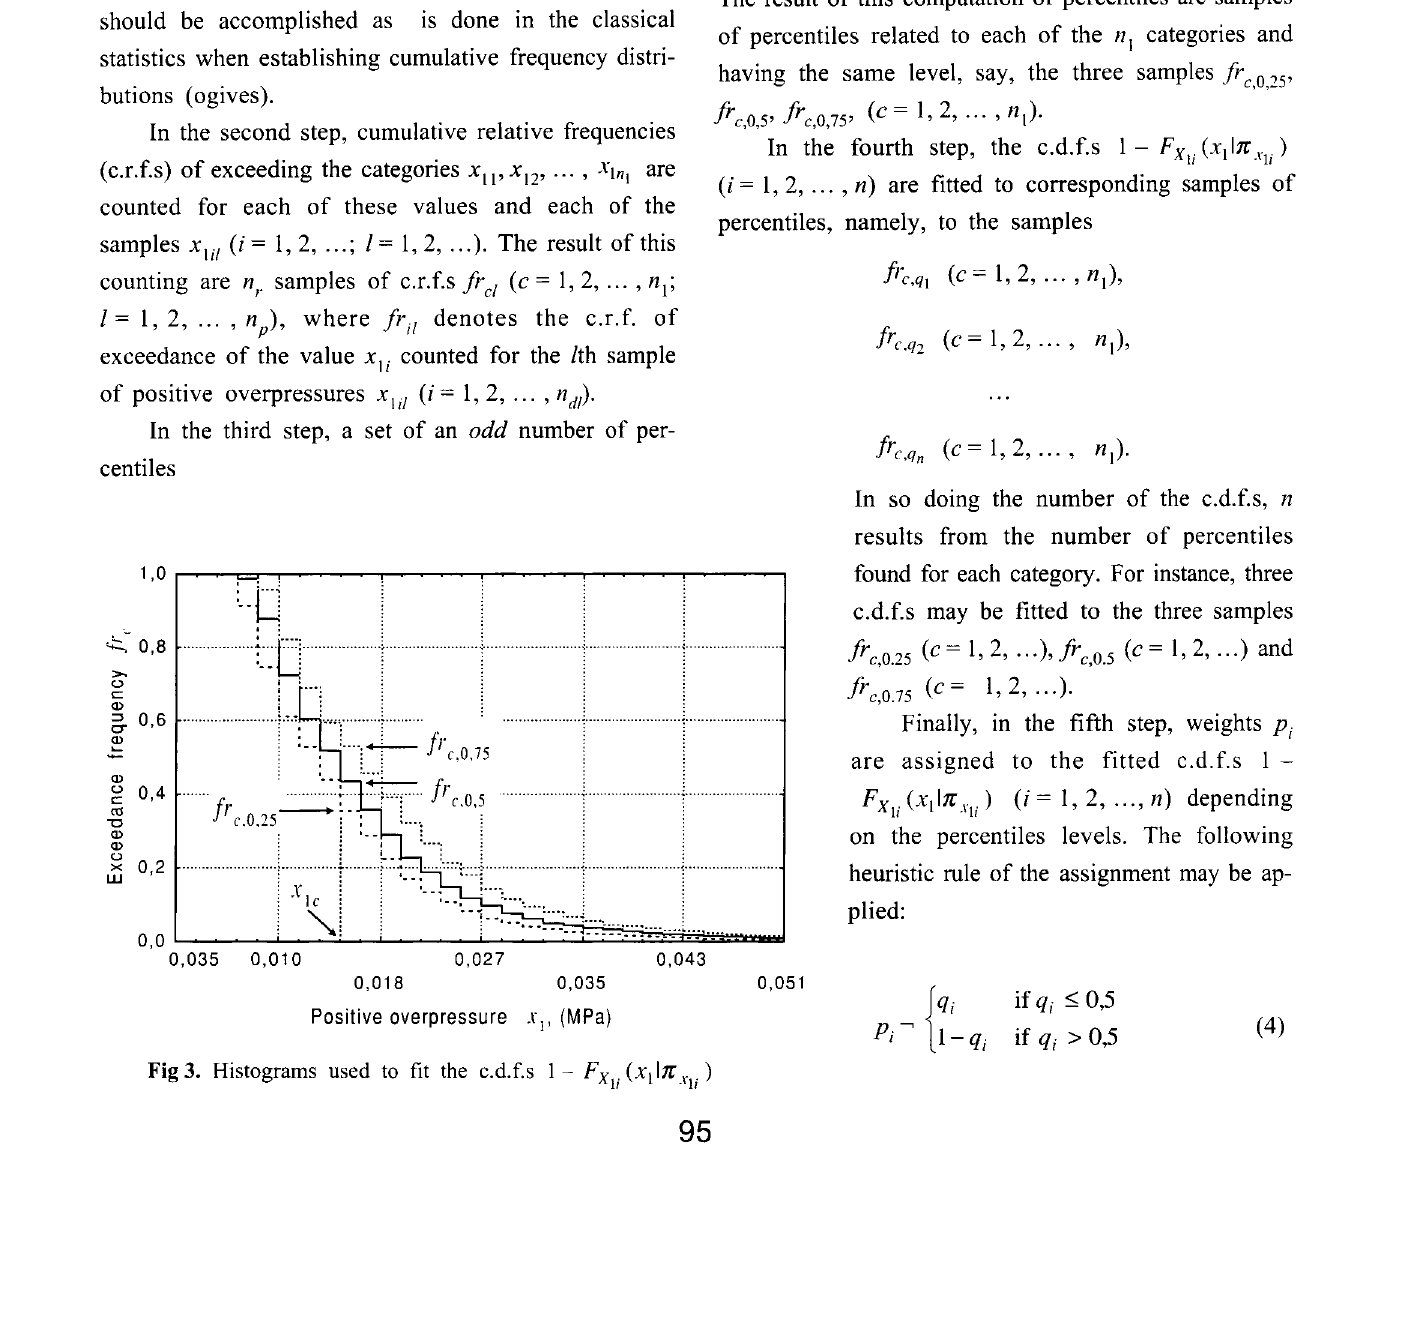
Fig3. Histograms used to fit the c.d.f.s 1-